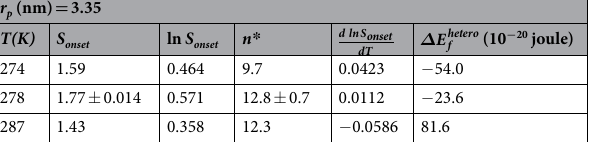
and T listed in the table by differentiating the parabola deter- onset